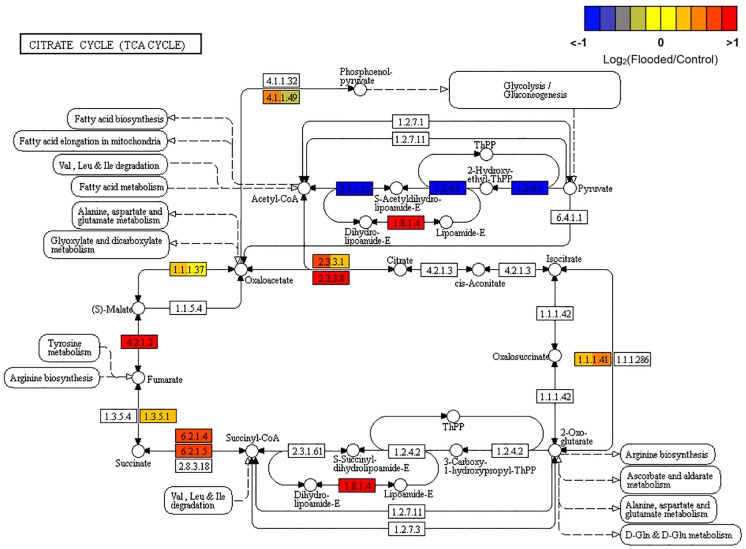
KEGG map of the Citrate Cycle (TCA cycle; map00020) pathway, rendered by Pathview (Luo et al., 2017). Each box is divided in three sub-boxes and represents a specific enzymatic step with the relative expression of the corresponding genes in Flooded versus Control roots, calculated as log2-ratio at T1, T2, and T6 (from left to right).